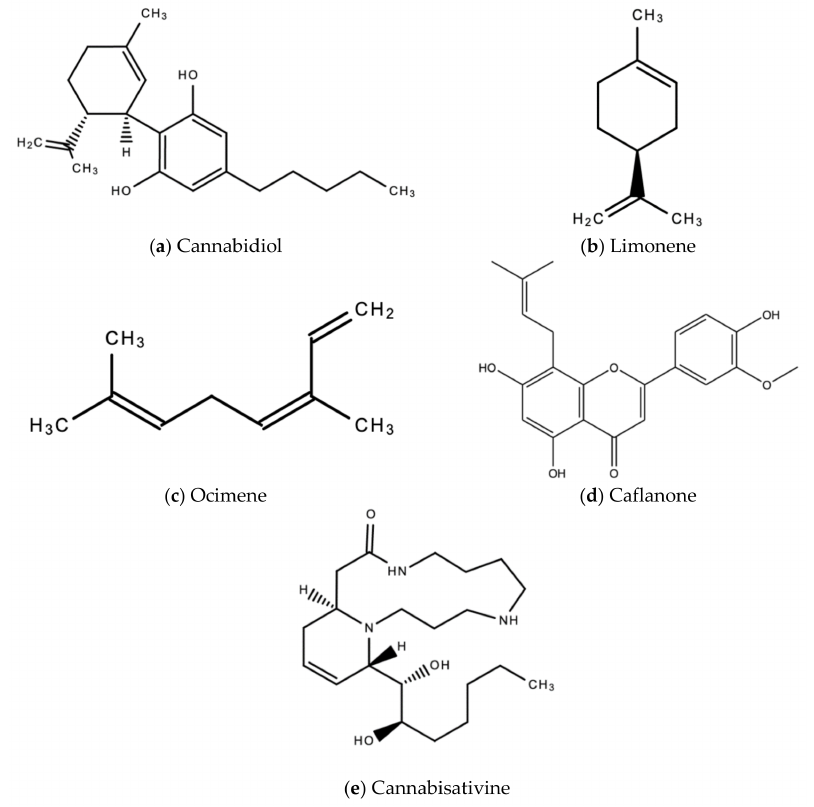
Figure 4. Chemical structures of some bioactive molecules found in C. sativa